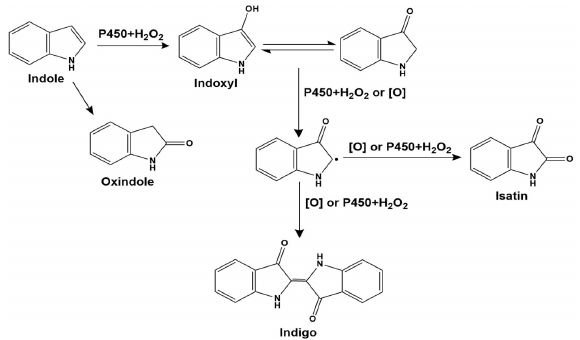
Scheme 1. A plausible reaction mechanism for indigo formation from indole catalyzed by P450BM3